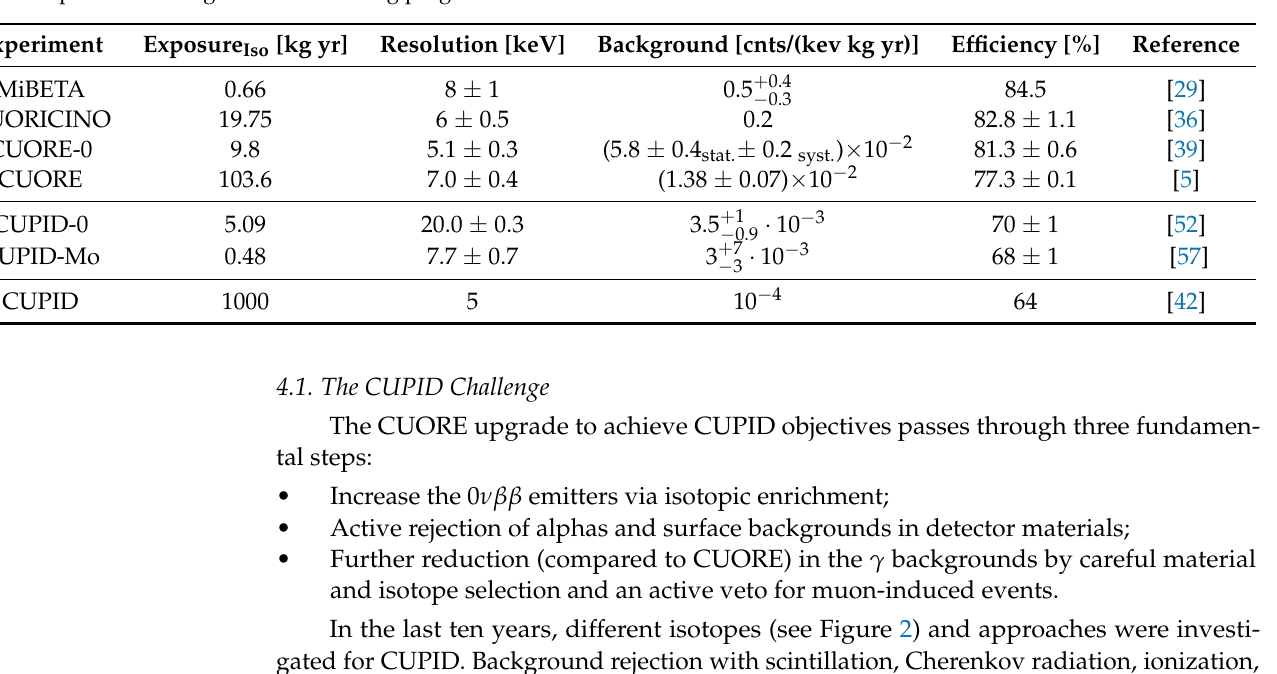
Table 1. Performance of different 0 νββ experiments based on cryogenic calorimeters. The data are measured for all of the experiments except for CUPID, where the best prediction of performances at the end of the operation time was reported, as derived from Monte Carlo simulations. CUORE data reflect the latest published results, and therefore these performances are expected to change as its data taking progresses.